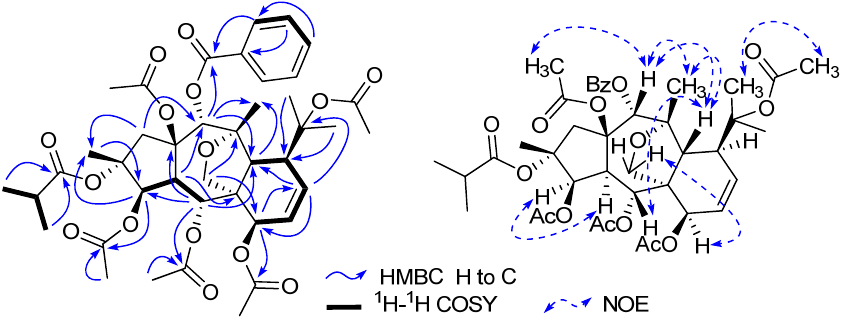
Figure 2. Selected HMBC, 1 H- 1 H COSY, and NOESY correlations of compound 1